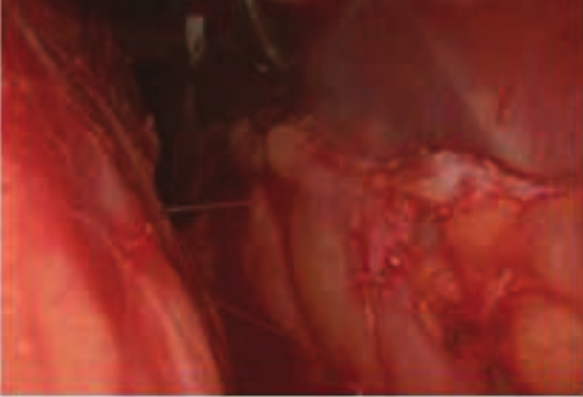
Figure 2: Fasciotomy endoscopic, is created a wide fenestration exposing under fascial plans